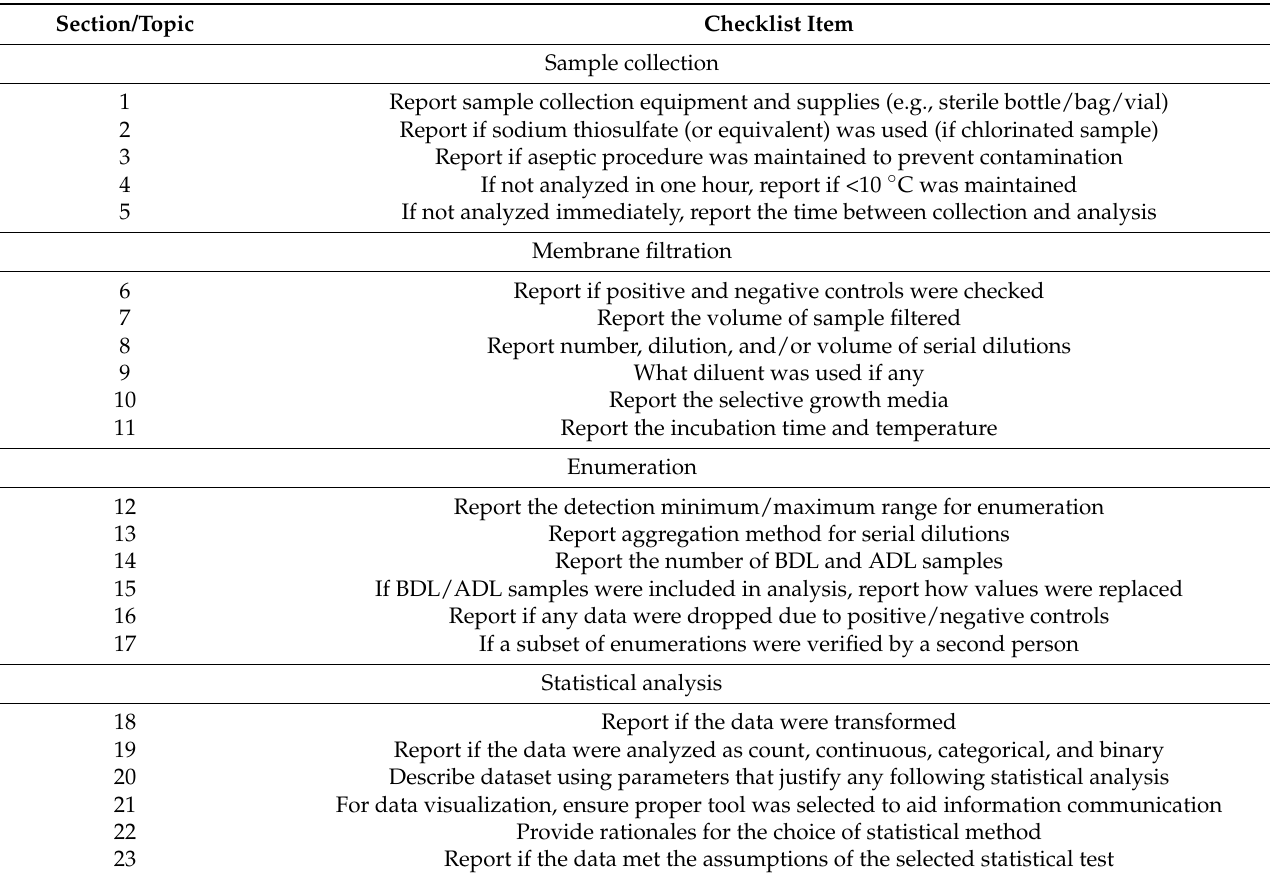
Table 4. Checklist of recommended parameters to report in manuscripts including membrane filtration data from low- and middle-income countries